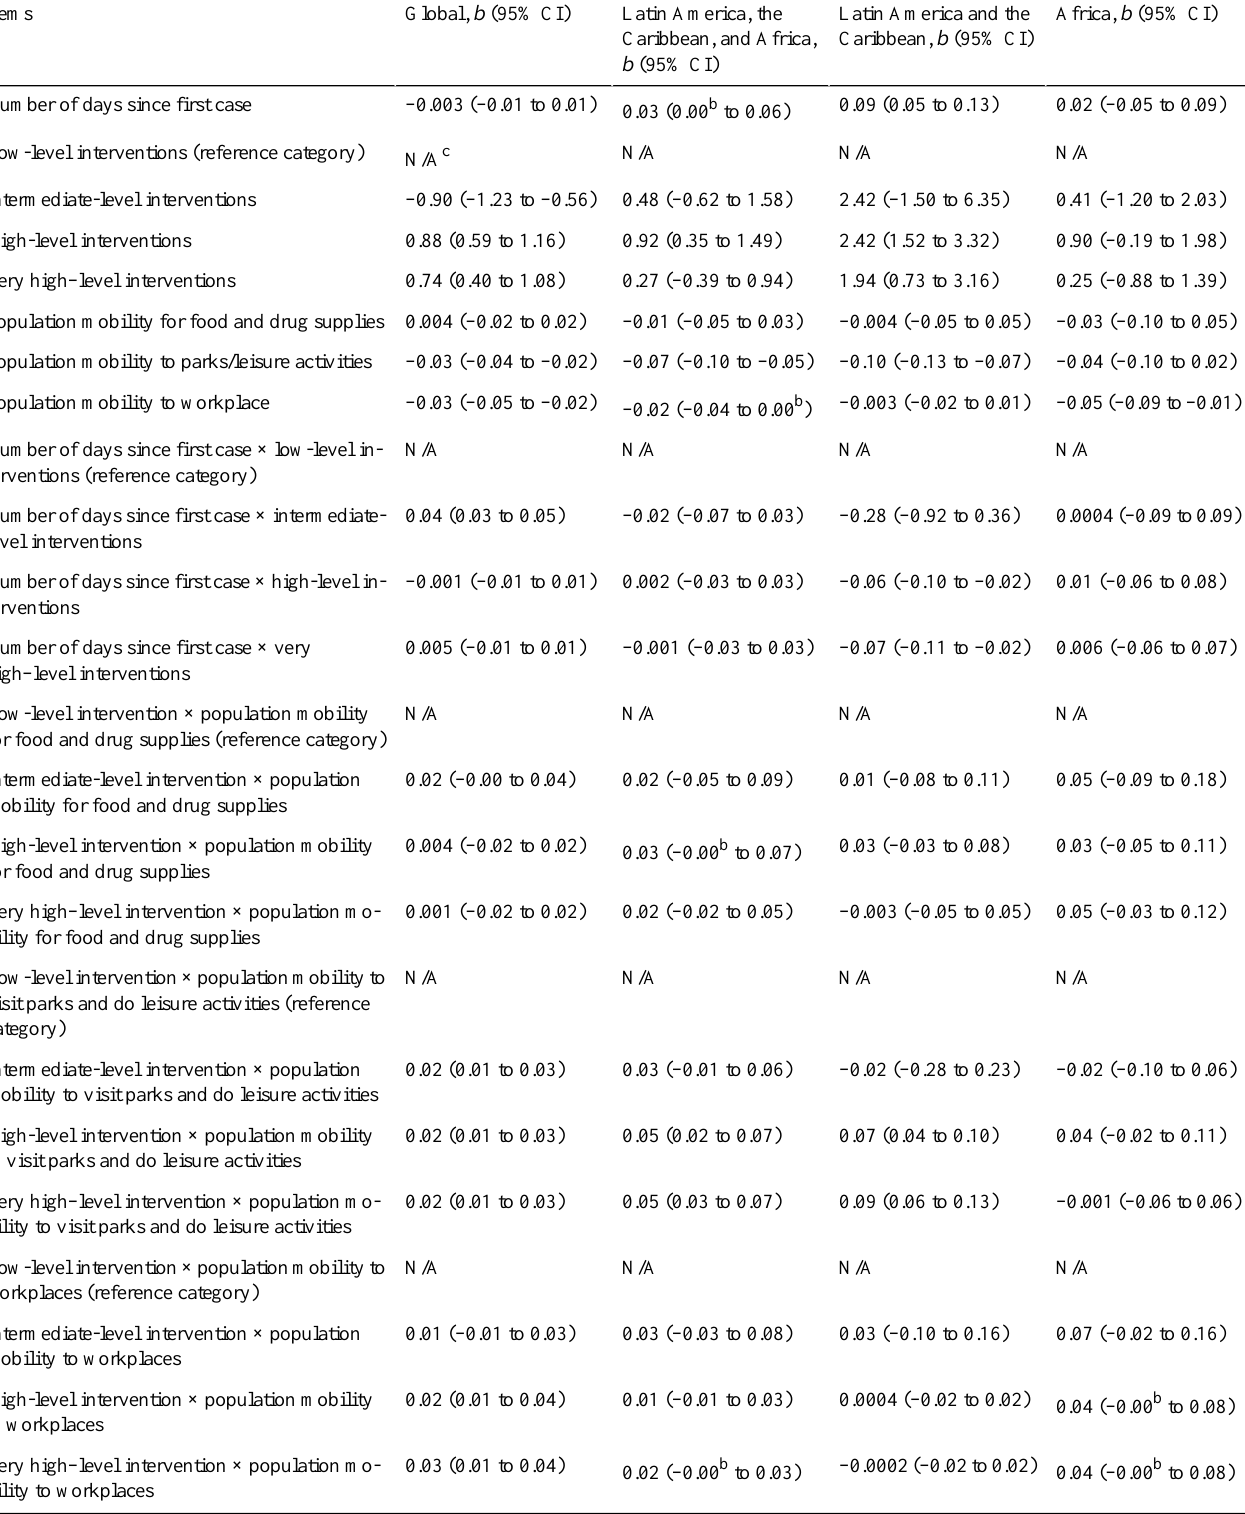
Table 3. Results from mixed model analysis that evaluated the COVID-19 spread with government interventions, their interaction with population mobility patterns, and other factors during the first 4 months of the outbreak.